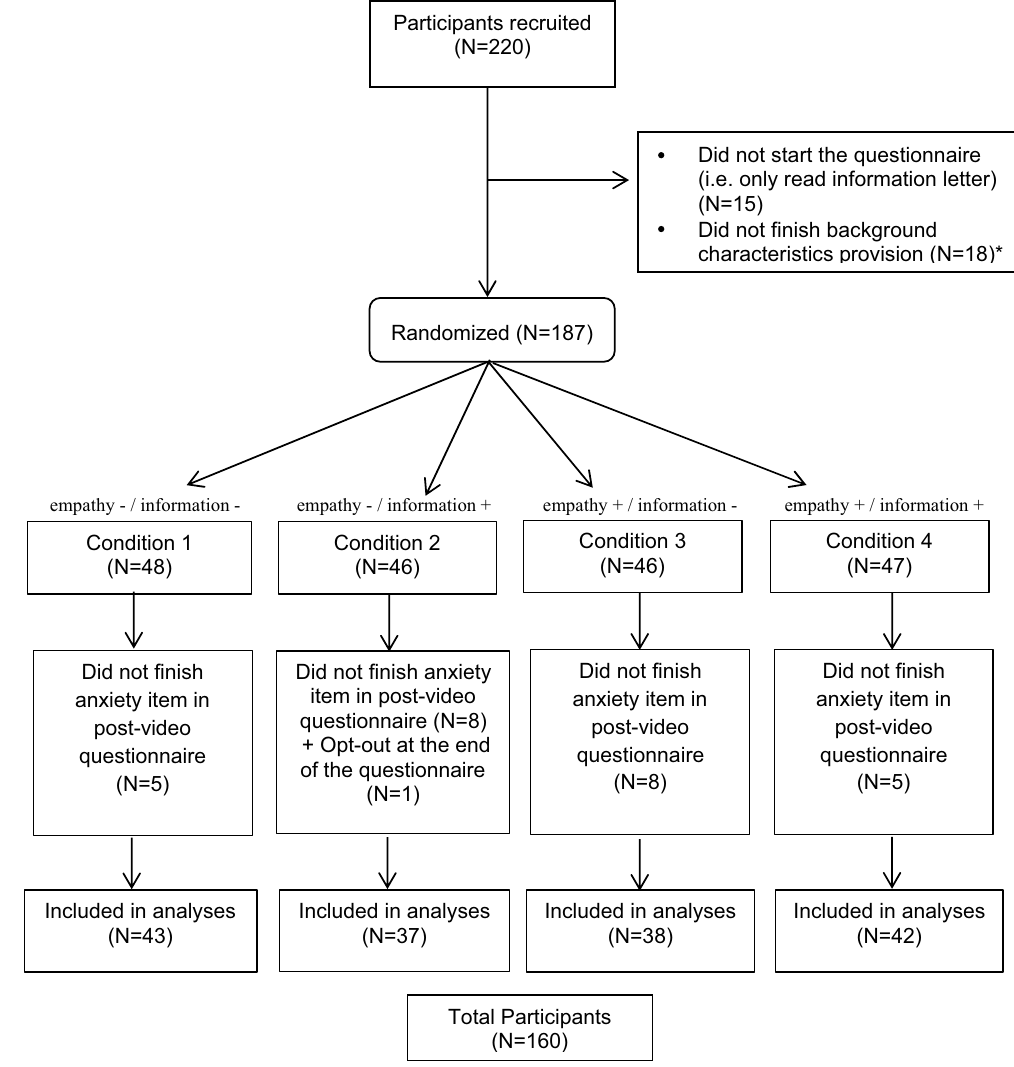
Figure 1. CONSORT diagram showing randomization assignment and participant flow by the group. *Randomization took place after background characteristics had been provided. Drop-out during background characteristics provision was n = 33; drop-out after randomization was n = 28. Data collection took place between February 8 and April 19,